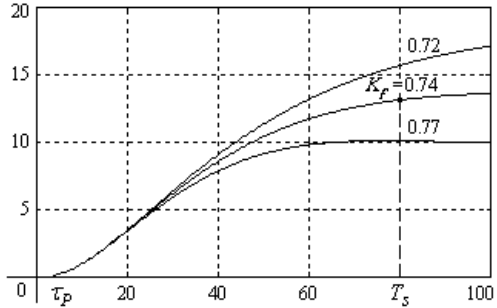
Figure 32. Compensated process responses to a unit step input.